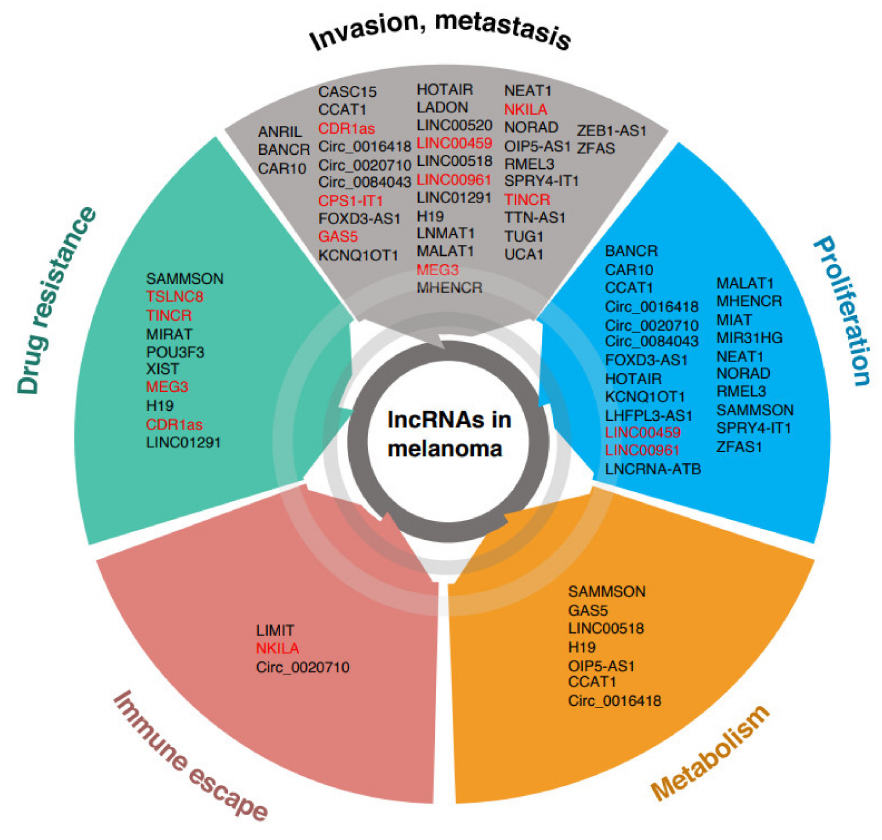
Figure 1. Overview of lncRNAs associated with major hallmarks of melanomagenesis. Melanoma tumor suppressor lncRNAs are highlighted in